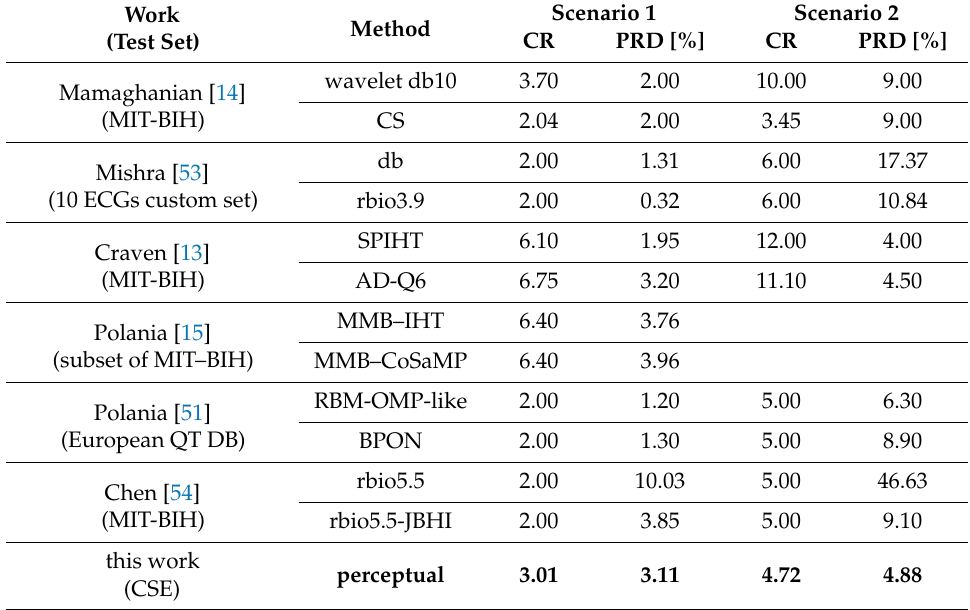
Table 2. Performance of the proposed adaptive sampling method compared to recent landmark systems for ECG compressed sensing; NB authors use di ff erent data sets for